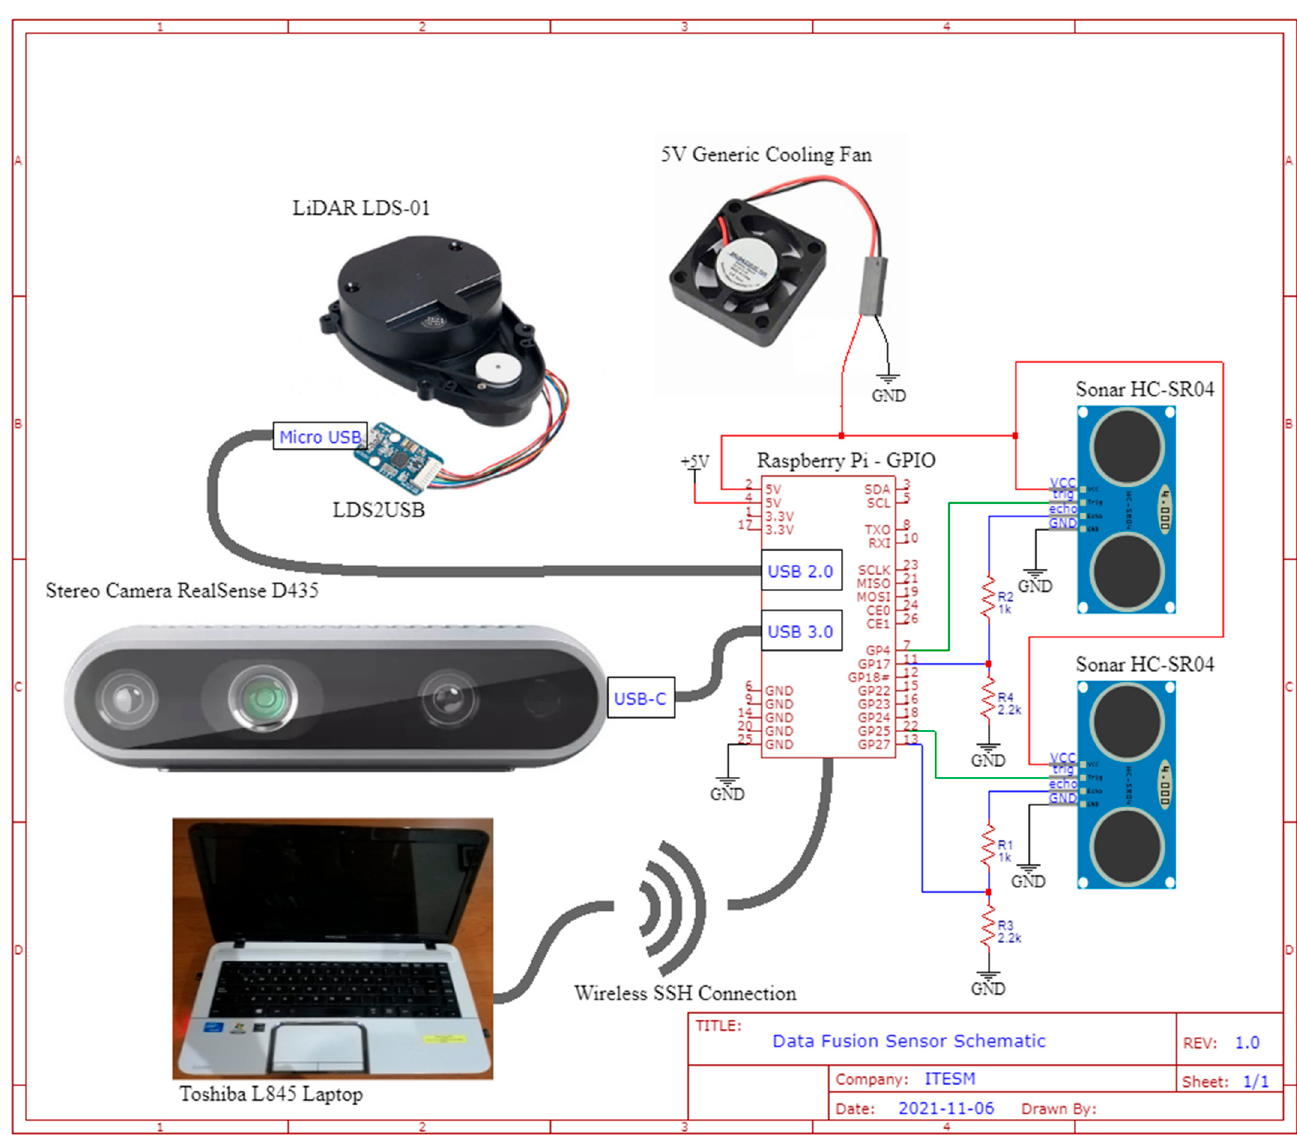
Figure 7. Sensor’s electrical connections schematic to the Raspberry Pi.